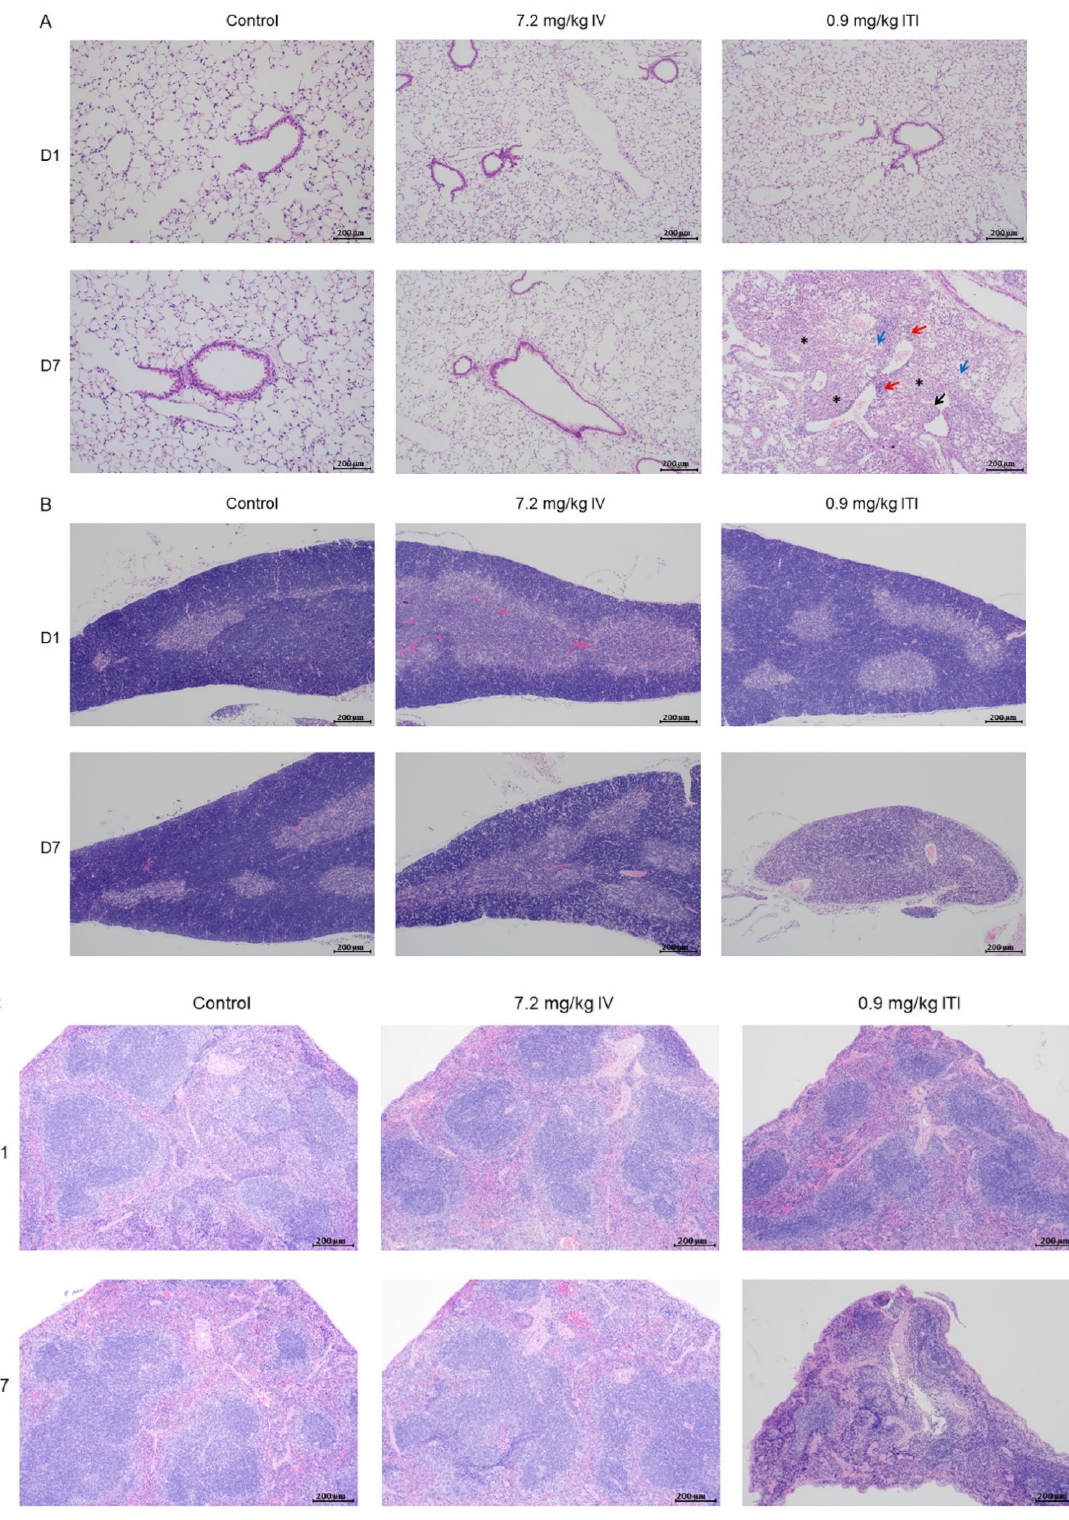
Figure 2. Histopathological examination of PHMG-P-treated mice: Representative photographs of lung ( A ), thymus ( B ), and spleen sections ( C ) are shown. Black arrow indicates degeneration of the bronchiolar epithelium; red arrows indicate the infiltration of inflammatory cells; blue arrows indicate foamy/alveolar macrophages; asterisk indicates fibrosis. Scale bar: 200 µm.